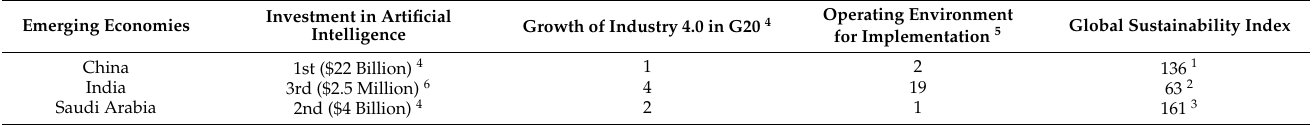
Table 1. Emerging economics and Technology